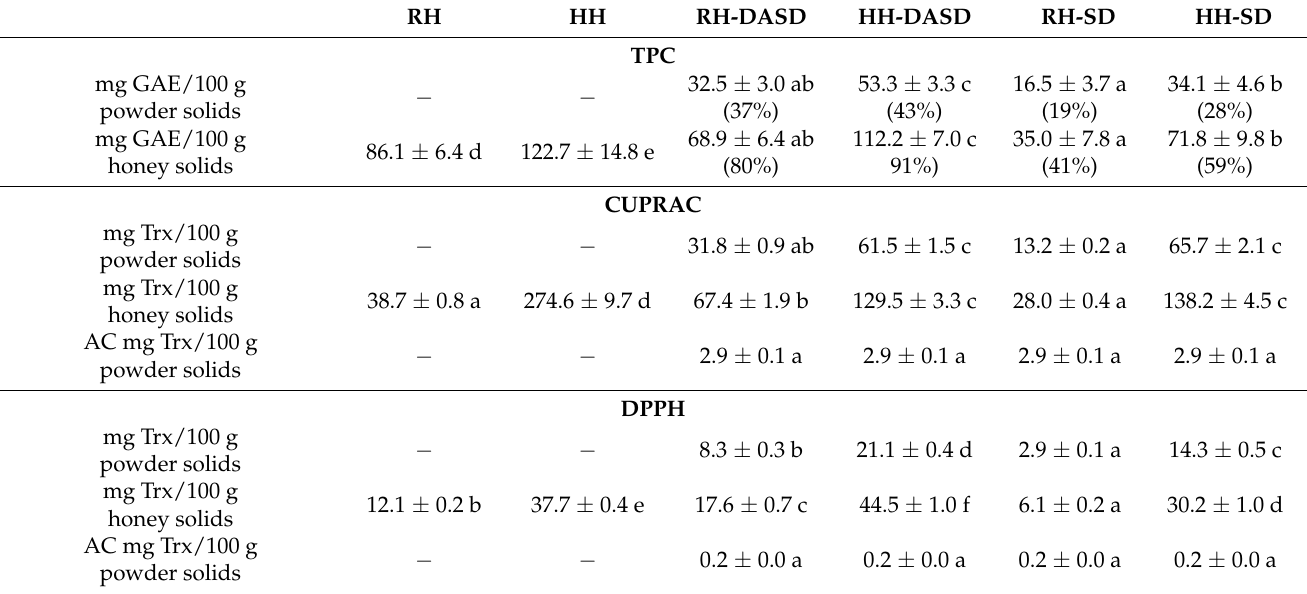
Table 2. Total phenolic content (TPC) and antioxidant activity (CUPRAC, DPPH) of rapeseed honey (RH) and honeydew honey (HH) powders obtained by traditional spray drying (SD) and dehumidified air spray drying (DASD); AC–activity introduced into the powders by the carrier; in brackets–relative retention in comparison to raw honey. a–f: differences between mean values followed by different letters in rows were statistically significant